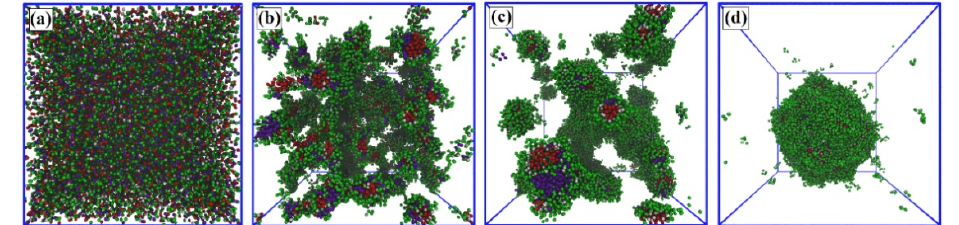
Figure 5. Aggregation of a system containing A 19 (4%), A 1 - b -S 6 (13%), and S 6 (3%) in a simulation system of size (40 R c ) 3 , with a sw = 65. The snapshots correspond to simulation times ( a ) initial state, ( b ) 1 × 10 3 , ( c ) 1 × 10 4 , and ( d ) 6.0 × 10 5 steps. The color scheme follows that of Figure 1.